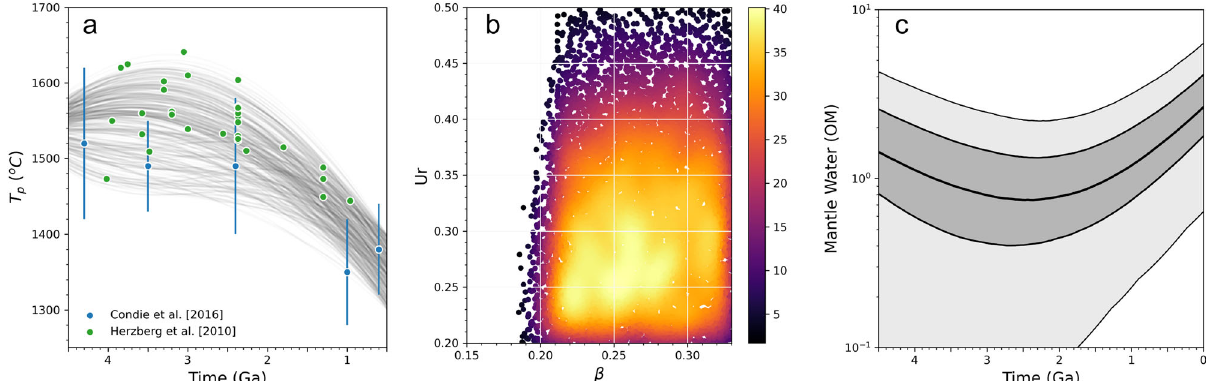
Fig. 3 Constraints on Earth ’ s thermal history require a change from net water loss to water gain at 2 – 3 Ga. Thermal trajectories consistent with Earth data ( a ) used for obtaining inversion results. b Successful Ur − β parameter space colored by relative point density with higher values meaning the density of points is larger. c Distribution of mantle water content about its median value, with the dark gray indicating values falling between the upper and lower quartiles and the lighter gray constraining the maximal and minimal